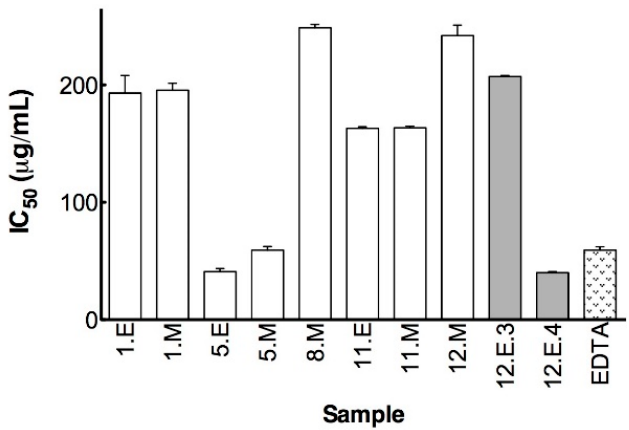
Figure 8. Collagenase inhibition activity (IC 50 values) by extracts. EDTA was used as reference.